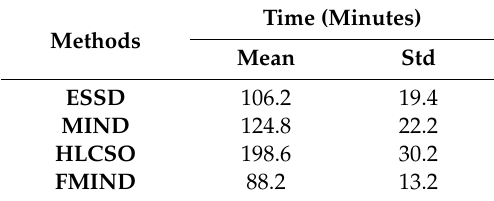
Table 6. Computation time for all evaluated methods operating on the 3D CT–PET image pairs.